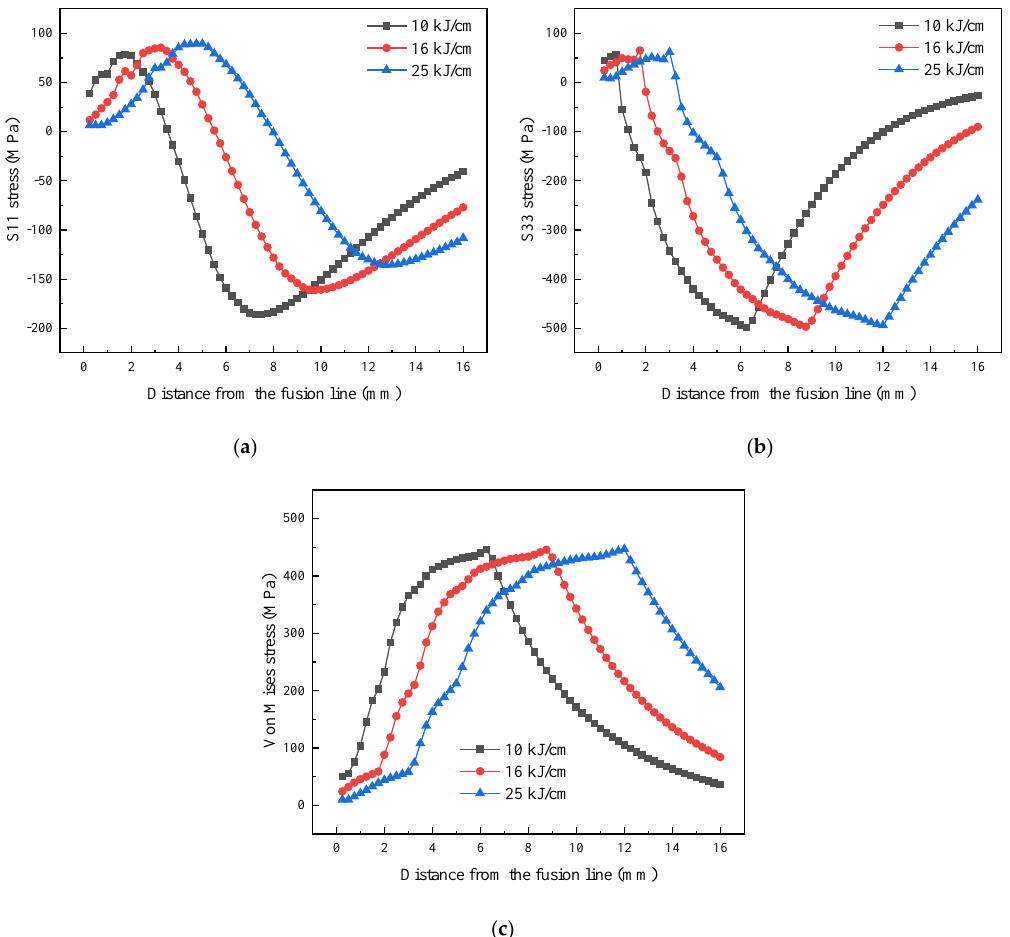
Figure 19. Stress distribution at a depth of 0.5 mm in the HAZ at the end instant of repair welding for different linear energy: ( a ) S11 stress in the HAZ; ( b ) S33 stress in the HAZ; ( c ) Von Mises stress in the HAZ.